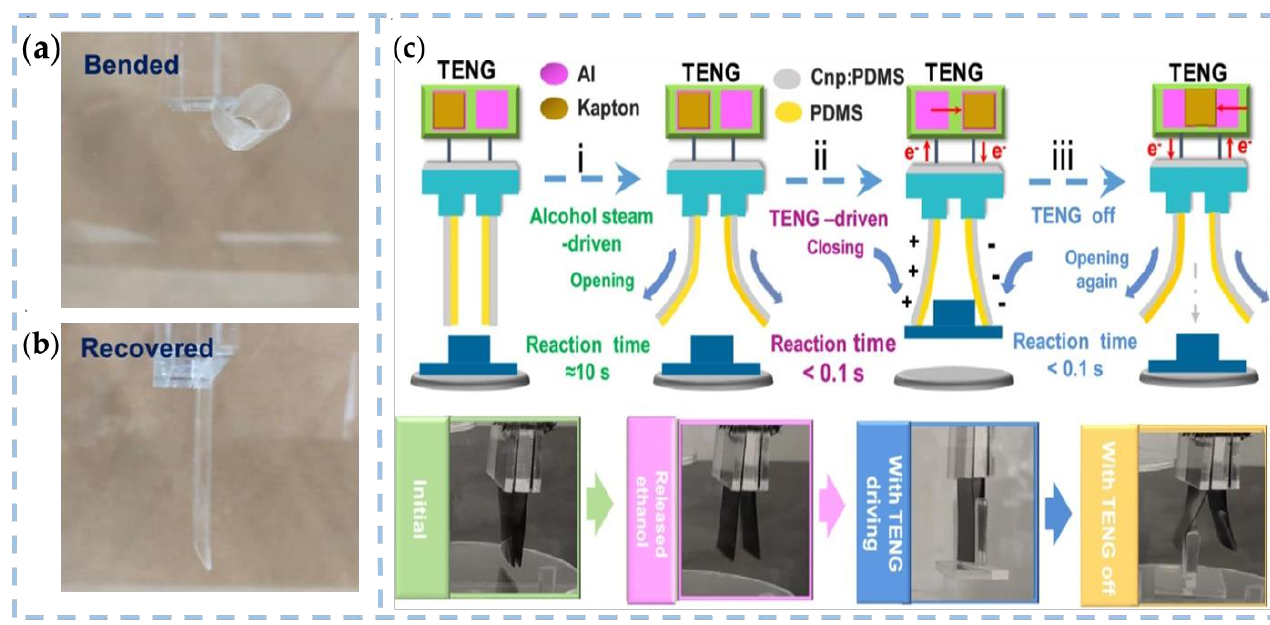
Figure 10. ( a , b ) Curling and recovery process of the PDMS film [65]. Copyright 2019, AMER CHEMICAL SOC. ( c ) Working principle and three working processes of the dual-stimulus flexible gripper based on TENG and vapor induction: (i) ethanol vapor drives the gripper to open, (ii) TENG drives the gripper to hold the object, (iii) TENG reopens the gripper and unloads the object [107]. Copyright 2022, ELSEVIER.